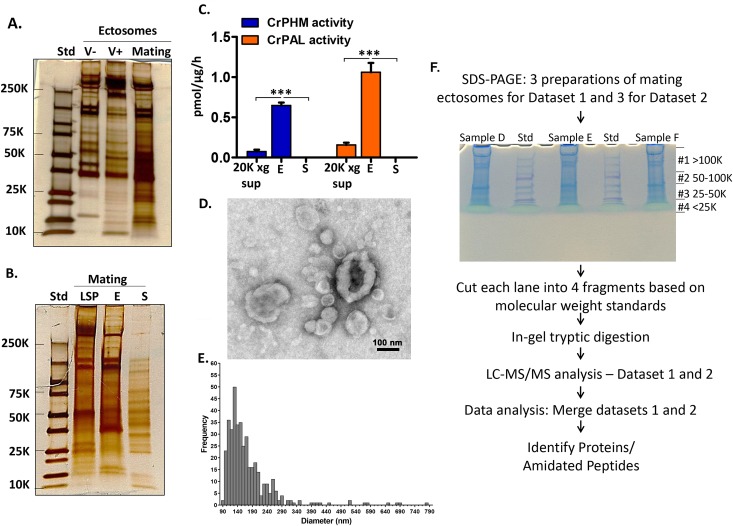
Biochemical characterization of ectosome-rich pellets.A. Comparison of ectosome-rich pellets (2 μg protein/lane) prepared from vegetative cells incubated for 4 hours and from gametes mixed and allowed to mate for 1 hour. Proteins were visualized using silver stain. Std, molecular weight markers. B. Comparison of proteins in the mating gamete low-speed pellet (LSP, 2 μg protein), ectosome-rich pellet (E, 2 μg protein), and soluble secretome (S, 40 μL corresponds to approximately 80 μg cell protein); proteins were visualized using silver stain. C. CrPHM and CrPAL activities were measured in the 20,000g supernatant (20Kg sup), ectosome-rich pellet (E), and soluble secretome (S); specific activities are the average of three independent experiments ± SEM (***P < 0.0001; one-way ANOVAs). D. Negatively stained electron microscope image of the ectosome-rich pellet prepared from 1-hour mating medium of mixed minus and plus gametes. E. Histogram illustrating the size distribution of isolated ectosomes (mean ± SEM = 170 ± 14 nm; n = 400). F. Mating ectosome-rich pellets prepared from biological triplicates two independent times were subjected to mass spectrometric analysis. All six samples were separated by SDS-PAGE; after visualization with colloidal Coomassie, each gel lane was sliced into four fragments as shown. Proteins and amidated peptides were identified by mass spectrometric analysis (S2 Table). The underlying numeric data for this figure can be found in S1 Data.